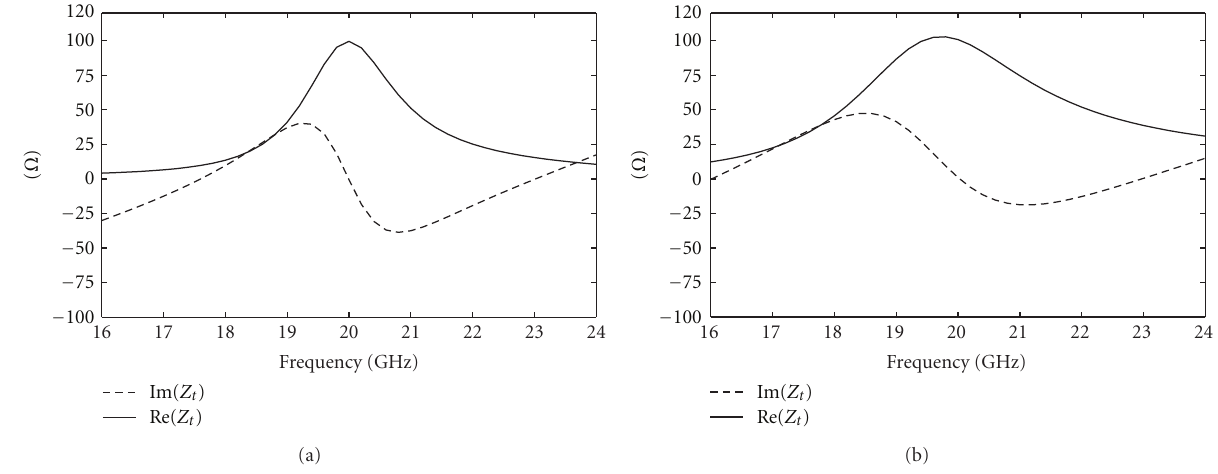
Figure 11: Simulated input impedance Z t —(a) Δ x = Δ y = 0 . 6 λ ; (b) Δ x = Δ y = 0 . 4 λ .